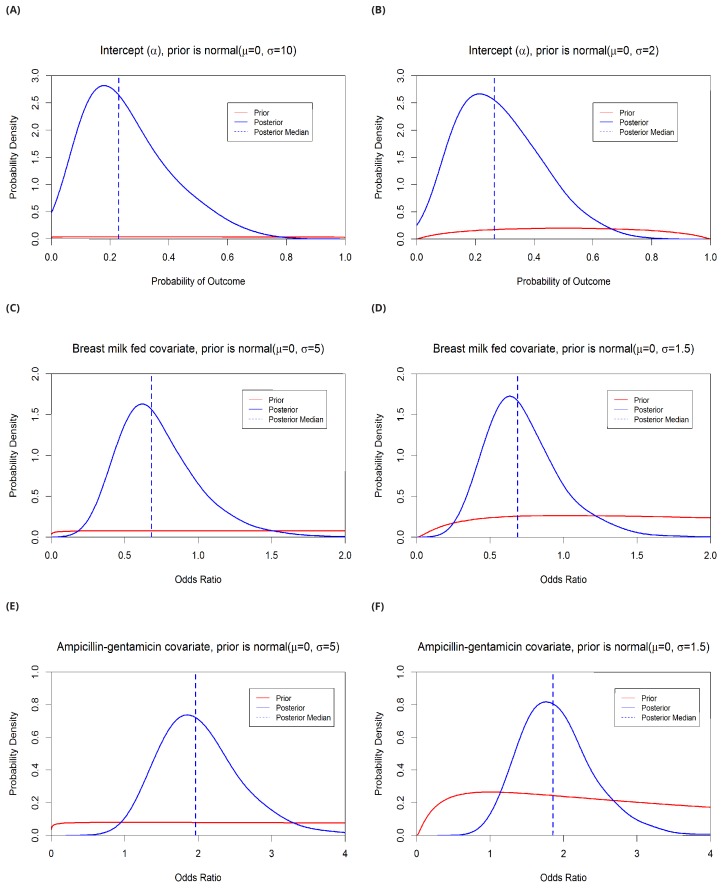
Estimates from risk factor model A with variable priors.The intercept (α) prior is varied from normal (μ=0, σ=10) to normal (μ=0, σ=2). This changes the median posterior probability from 0.23 to 0.26 (panels A and B). Covariate prior distributions were varied from normal (μ=0, σ=5) to normal (μ=0, σ=1.5). The median odds ratio for the effect of breast feeding on the risk of acquisition/detection of resistant Klebsiella pneumoniae changes from 0.68 to 0.69 (C–D), and the effect of taking ampicillin + gentamicin within the past 48 hours changes from 2.0 to 1.9 (E–F). Note that priors are fitted on the log-odds scale and that the prior and posterior distributions shown in this figure have been logit-transformed (A–B) or exponentiated (C–F).